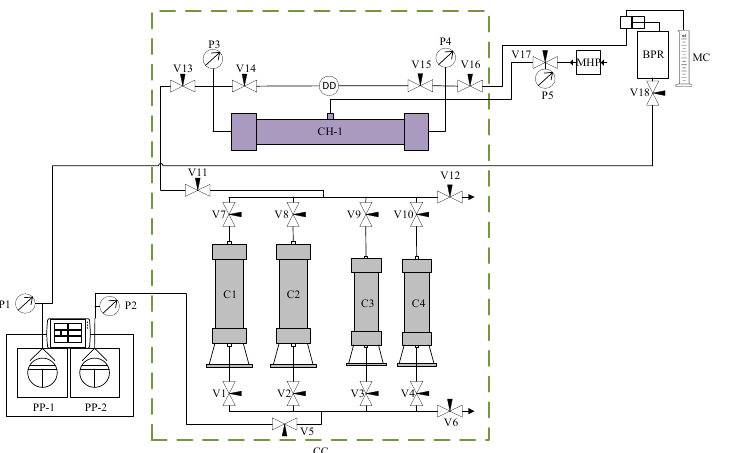
Figure 3. Schematic diagram of the filtration setup. PP-1, PP-2—high pressure plunger pumps; V1–V18—needle valves; C1–C4—piston liquid containers; P1–P5—gauge pressure sensors; DD—differen-